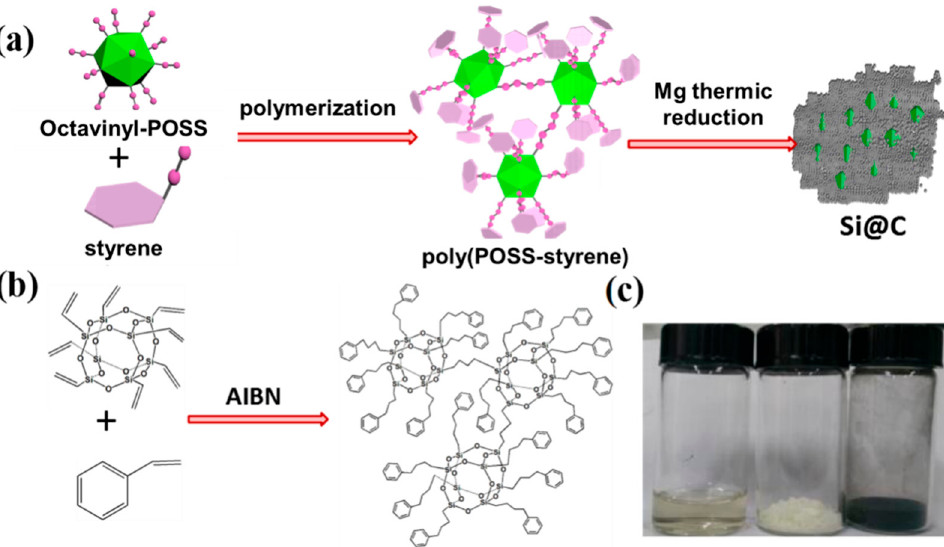
Figure 1. ( a ) Schematic illustration of synthesis of polyhedral oligomeric silsesquioxane (POSS)-derived Si@C anode material. ( b ) Formation of poly(POSS-styrene) between Octavinyl-POSS and styrene